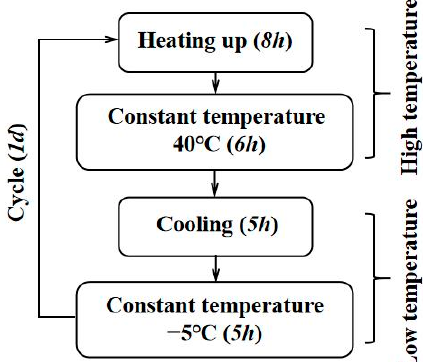
Figure 2. Geotextiles maintenance process.